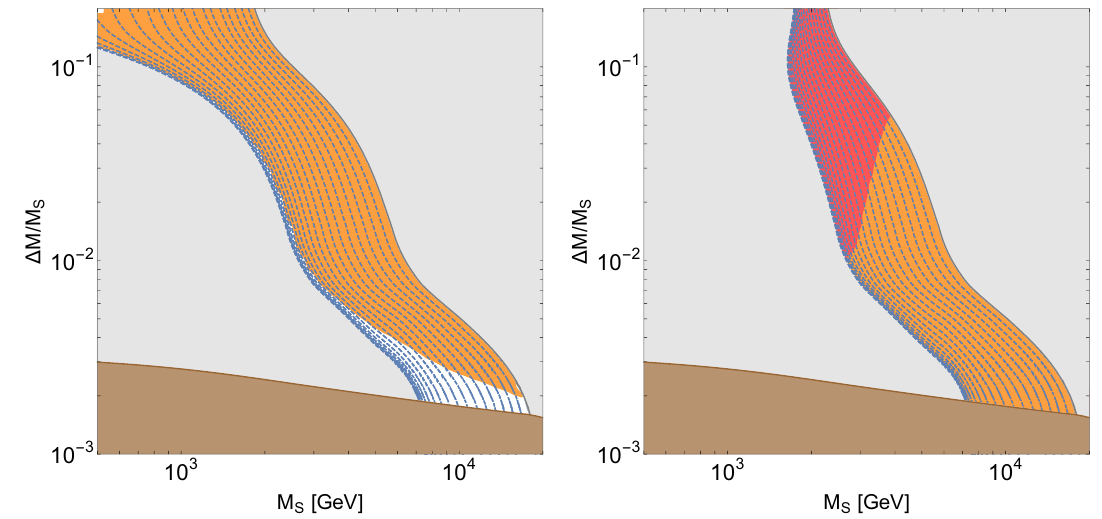
Figure 9 . Same as (cid:12)gure 8 for DM coupling to top quarks. Note that (cid:21) 3 always experiences non-negligible running for DM coupling to the top. The value of (cid:21) 3 ( (cid:22) ) = 0(1 : 5) has been (cid:12)xed at the scale of DM annihilations, (cid:22) = M S in the left (right)